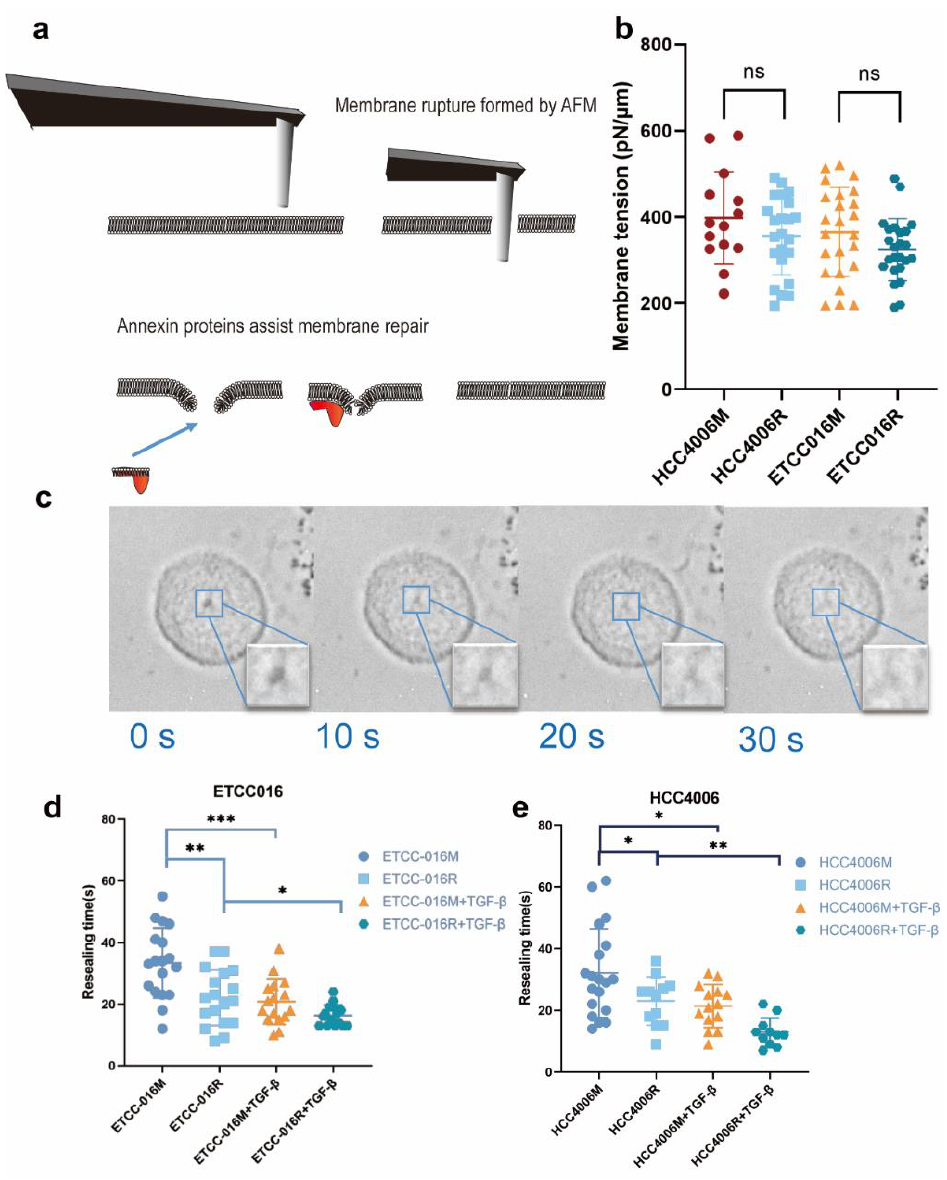
Figure 1. ( a ) An illustration of mechanical puncturing of the plasma membrane by a cylindrical AFM probe and its subsequent annexin-assisted self-repairing. ( b ) Membrane tension of different cells measured by AFM indentation. ( c ) A representative set of images showing the resealing of a membrane pore in the NSCLC cell line. Here, 0 s indicates the removal of the AFM probe. Clearly, the pore got smaller and smaller and eventually disappeared in ~30 s. ( d , e ) show the membrane resealing time measured from ETCC016 and HCC4006 cell lines under different treatments. Error bar represents standard deviation. (ns, not significant. ‘*’, ‘**’, ‘***’ represent p < 0.05, 0.01, 0.001, respectively, from unpaired t -test).